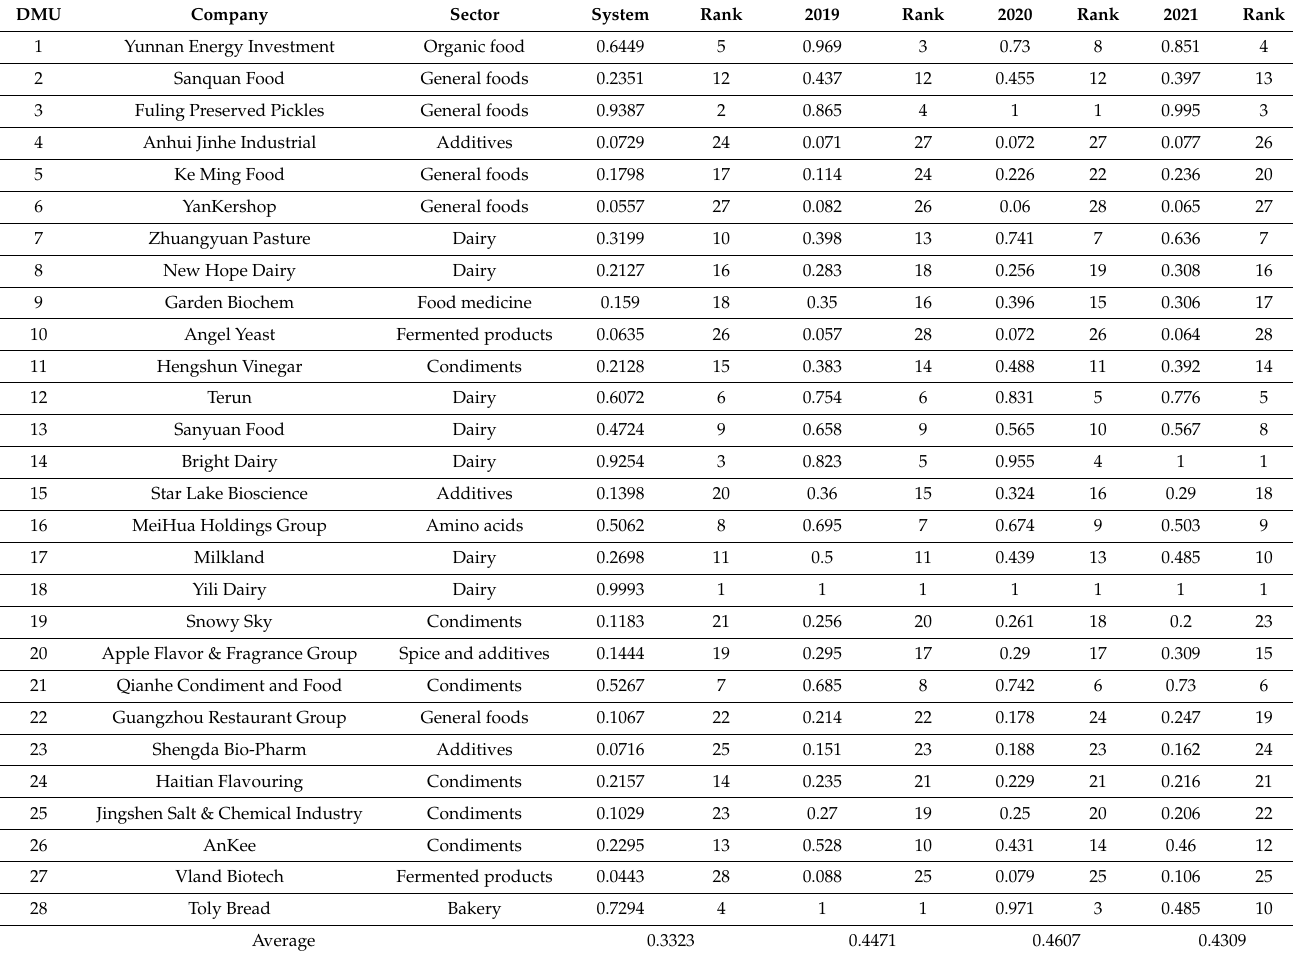
Table 6. R&D efficiency measures of food manufacturing companies in